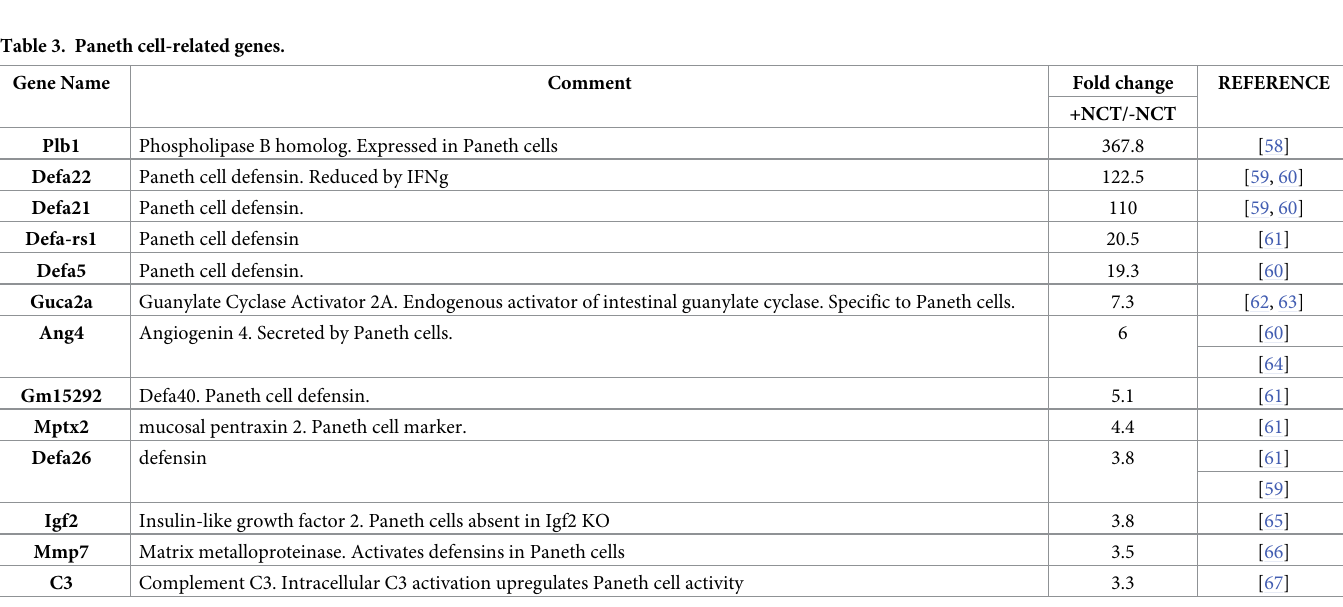
Table 3. Paneth cell-related